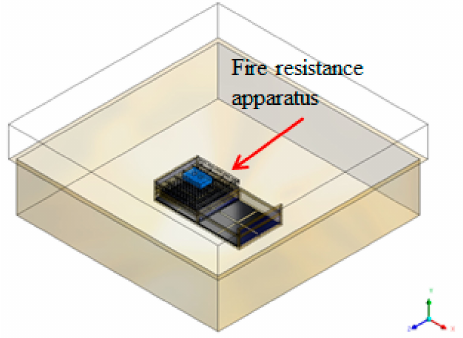
Figure 7. Volume of computation domain (10 m × 10 m × 4 m) used in CFD.